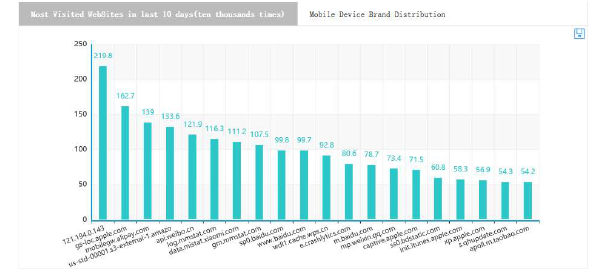
Figure 8. Popular